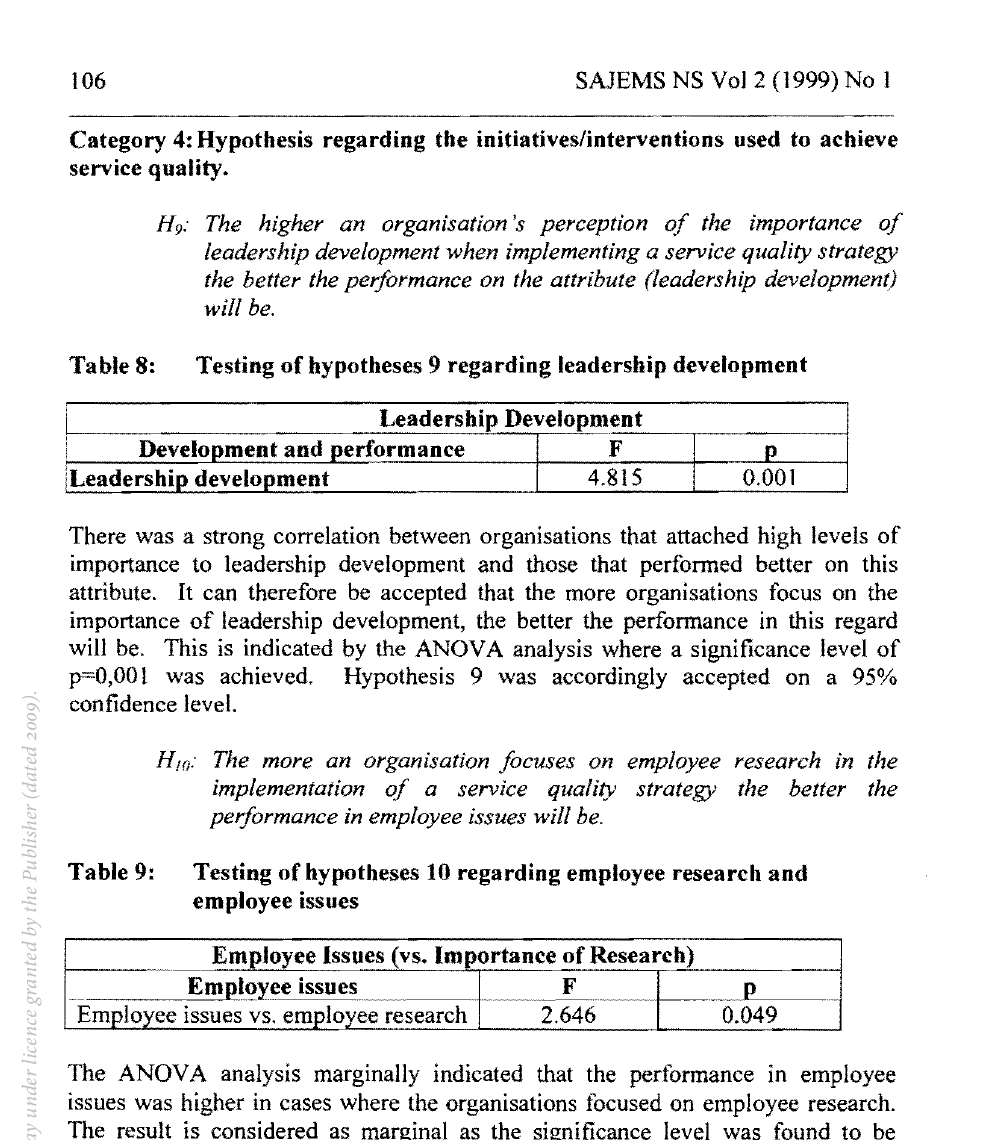
H9: The higher an organisation's perception of the importance of leadership development when implementing a service quality strategy the better the performance on the attribute (leadership development) will